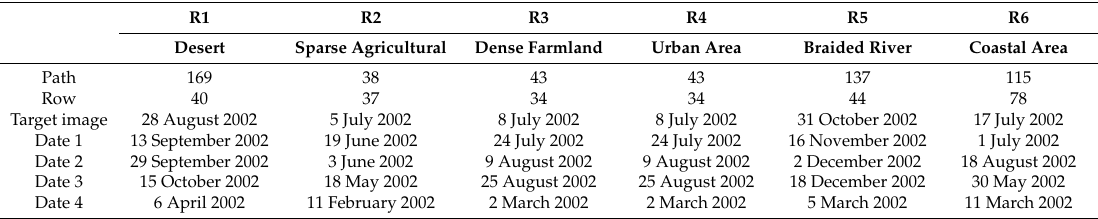
Table 2. The collection dates for the target images and the four input images used for informing the gap-filling